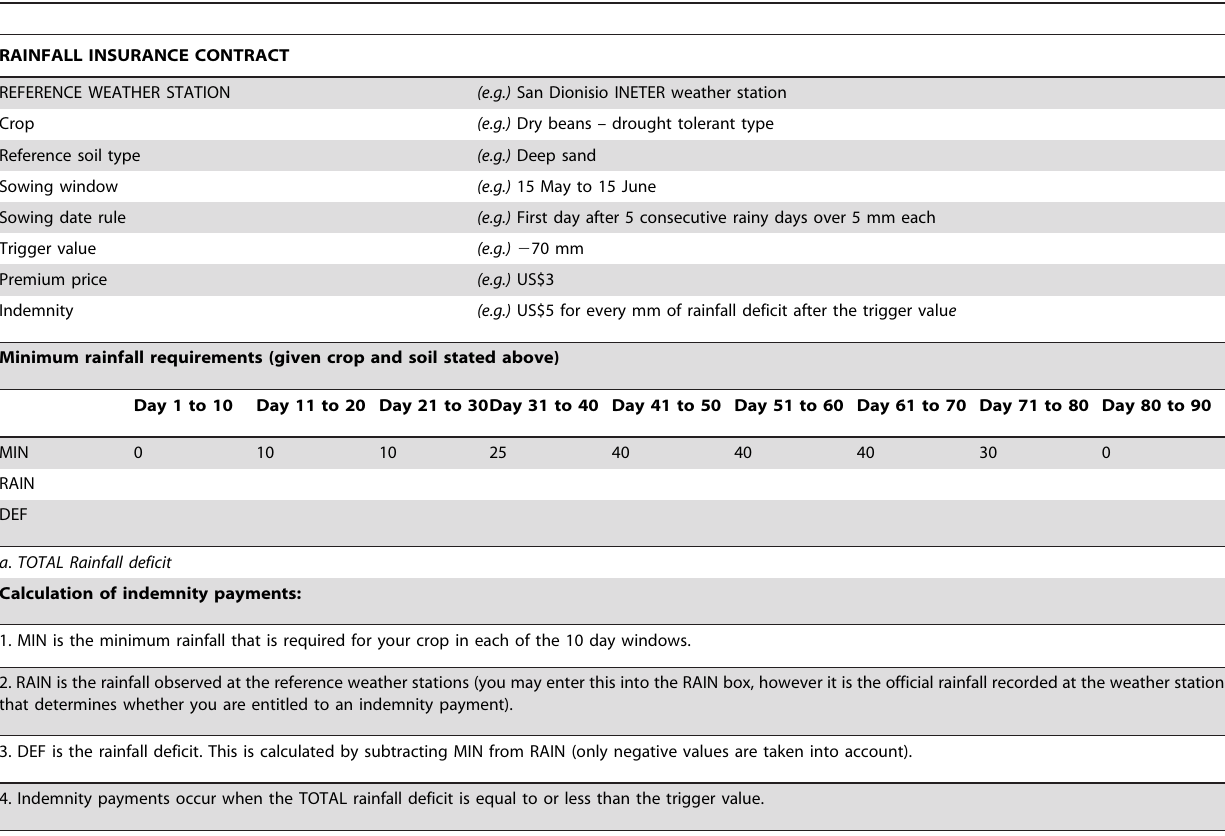
Table 3. Sample insurance